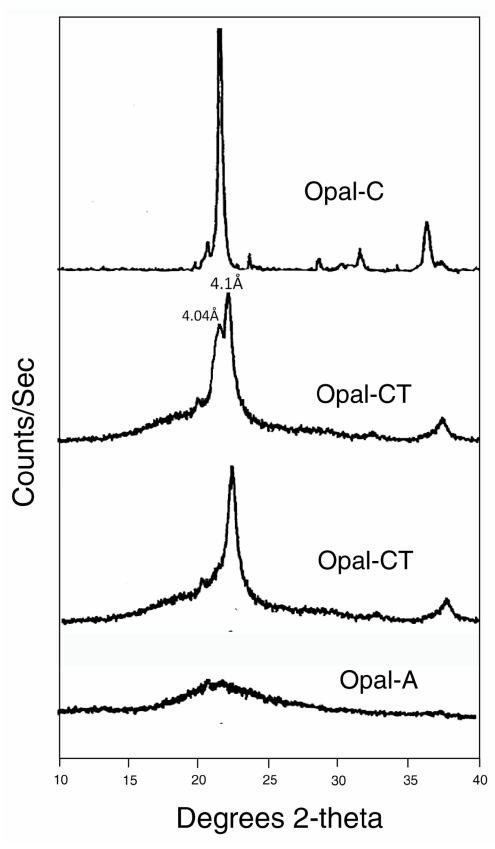
Figure 19. X-ray diffraction patterns for various forms of opal, using Cu- α radiation. Adapted from